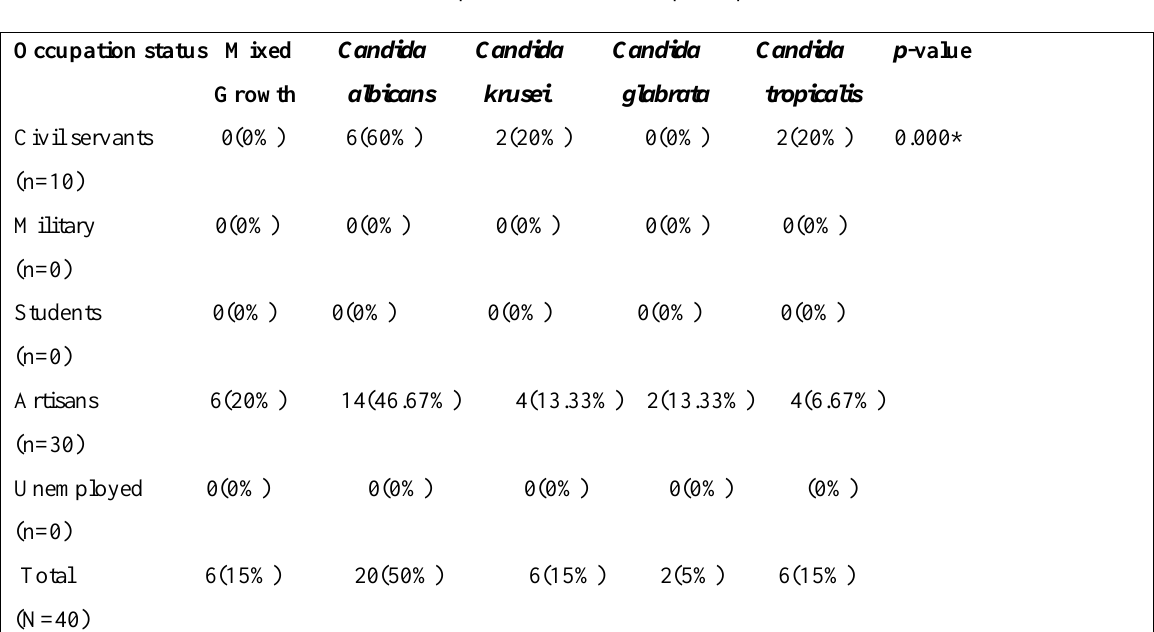
Table 9. Candida isolates based on the occupational status of the participants.